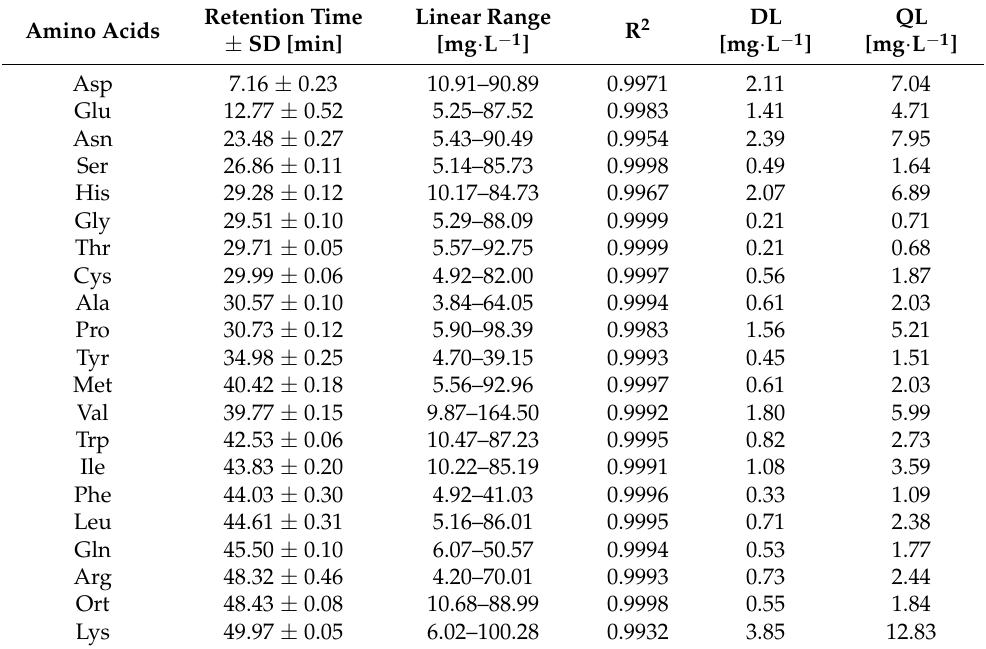
Table 1. Statistical parameters of amino acid calibration